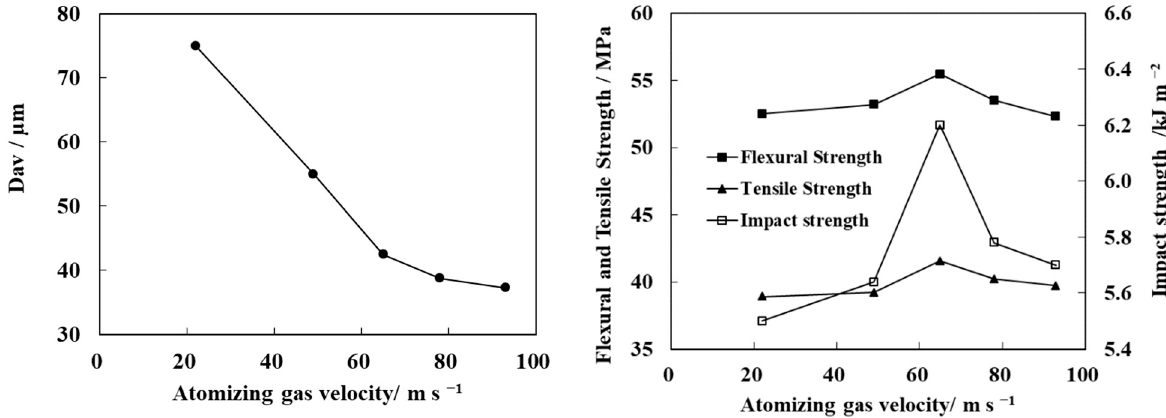
Figure 8. Effect of atomizing gas velocity on the average particle size of modified N-WPCB and the mechanical properties of PP/N-WPCB composites.